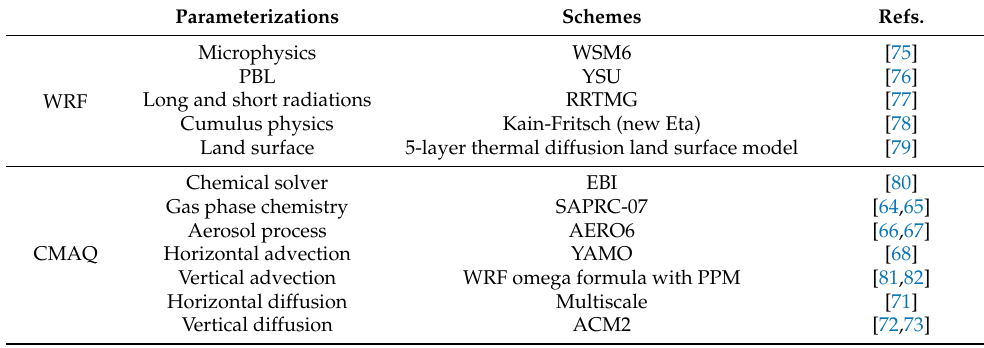
Table 2. Configuration of the WRF/CMAQ